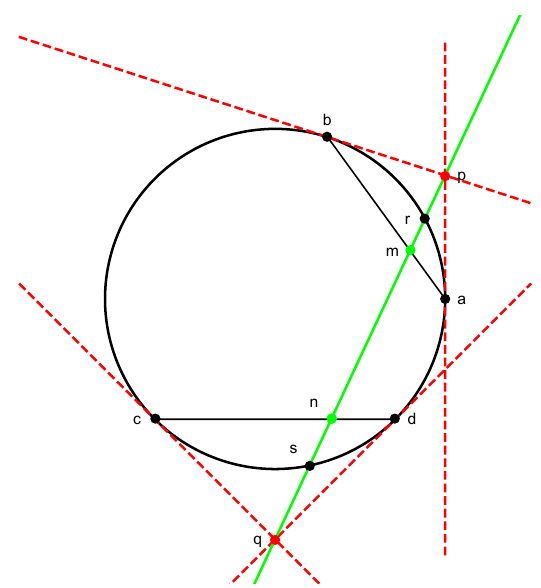
Figure 16. The RT surface is in red. The EP surface is in